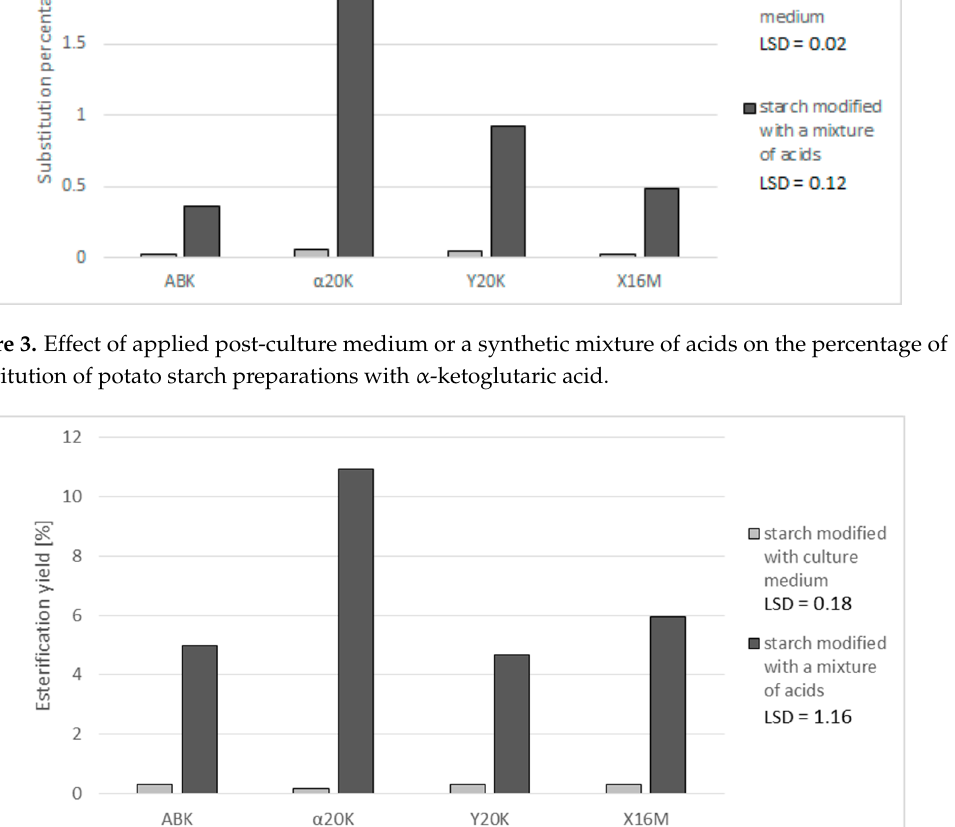
Table 1. Thermal analysis of starch preparations produced with post-culture media.